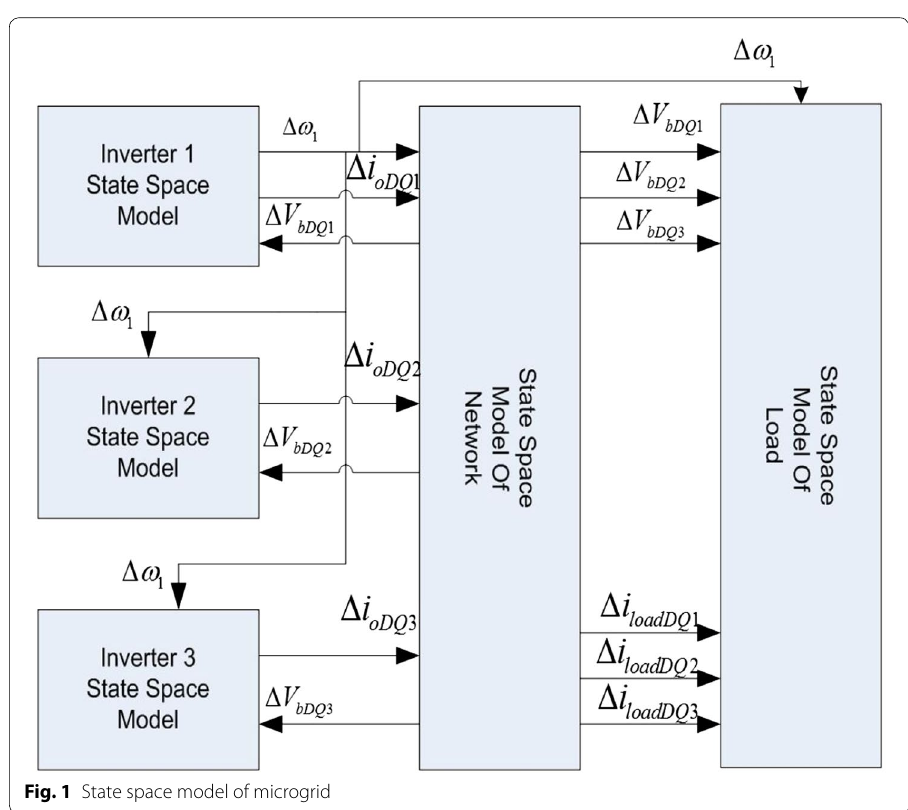
Fig. 1 State space model of microgrid